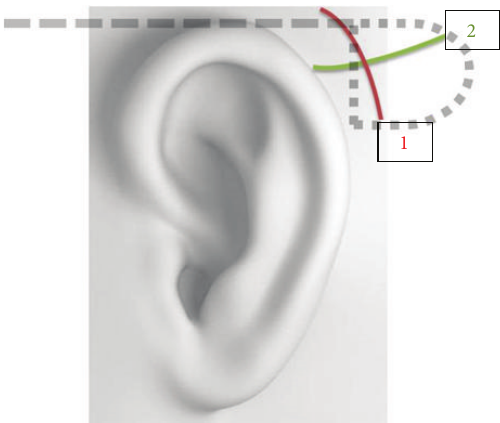
Figure4:Illustrationofthecurvedretroauricularincisionfollowing approximately the helix of the pinna (1) leaving the fascia of the temporal muscle intact. A second horizontal incision (2) was placed along the caudal limit of the temporal muscle crossing nearly perpendicularly the primary skin incision and providing a stabile two-layer wound closure.